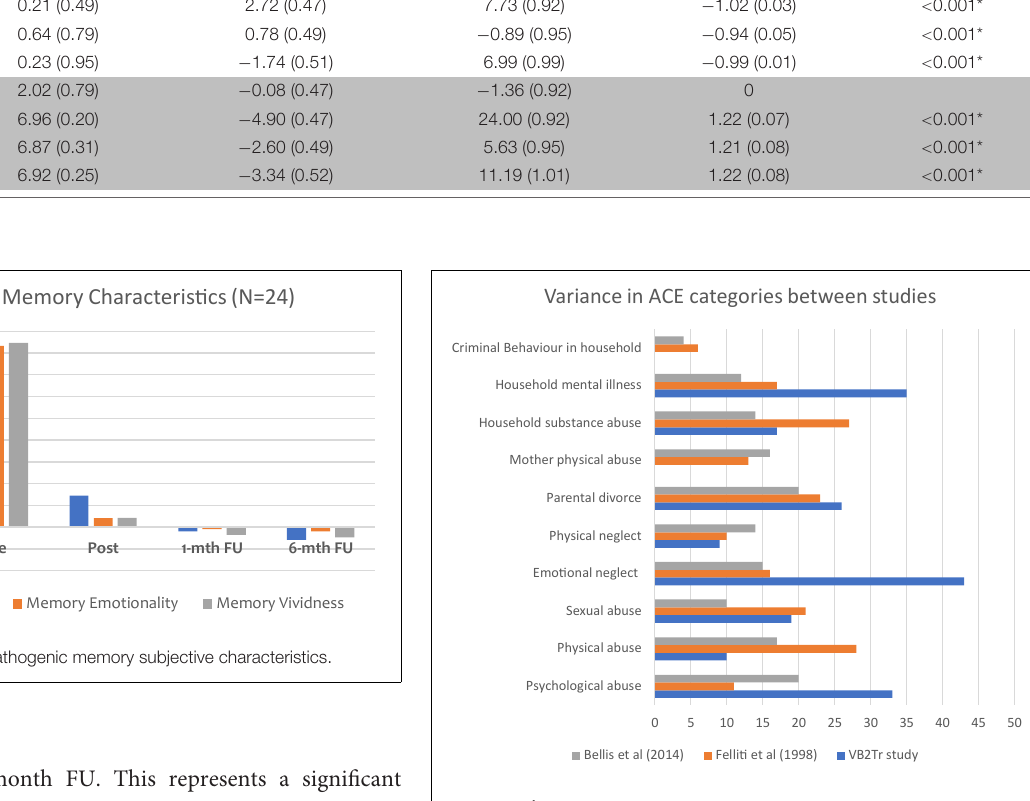
FIGURE 3 | ACE by category between studies.